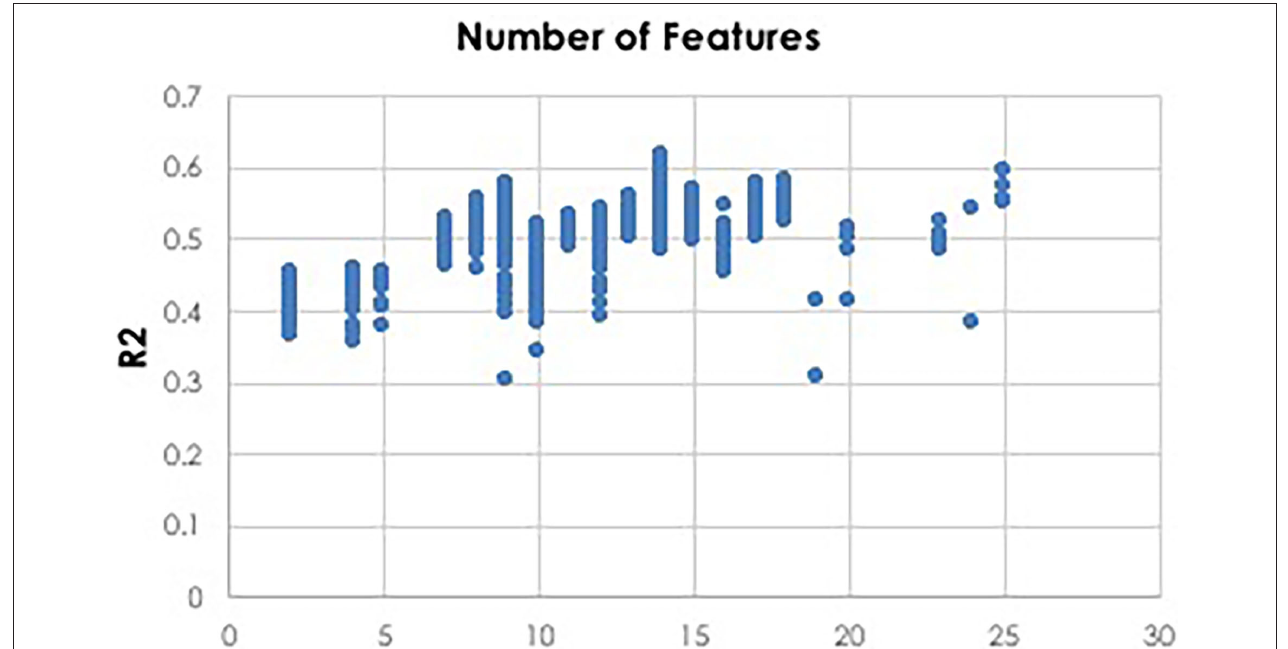
FIGURE 5 | Thresholding for warm start learning. Prior to beginning the recursive training portion of learning, a thresholding process is used to implement feature selection for a warm start to final learning. Here we show an example of deep learning with artificial neural networks to predict CBCL scores using regression. Plotting the R 2 metric against the number of features reveals that 14 features is optimal. A threshold value is then identified which constrains the available feature set for final recursive learning after the warm start to the 14 most important features identified during initial learning prior to the warm